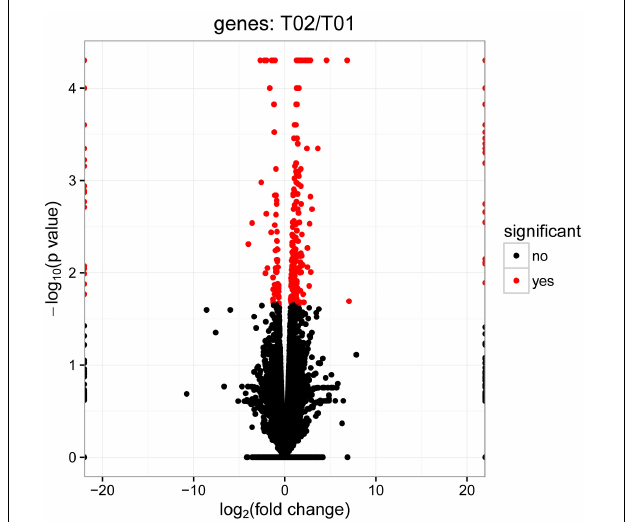
FIGURE 1 | Volcano plots of differentially expressed genes between control group and infected group. In the volcano plots, each dot is a gene, the “red” genes are those that were significantly regulated in infected group compared with control group at a q -value < 0.05. However, the “black” genes shown there were no significantly difference between control group and infected group. In total, 432 unigenes were identified as differentially expressed, including 307 genes that were up-regulated and 125 genes that were down